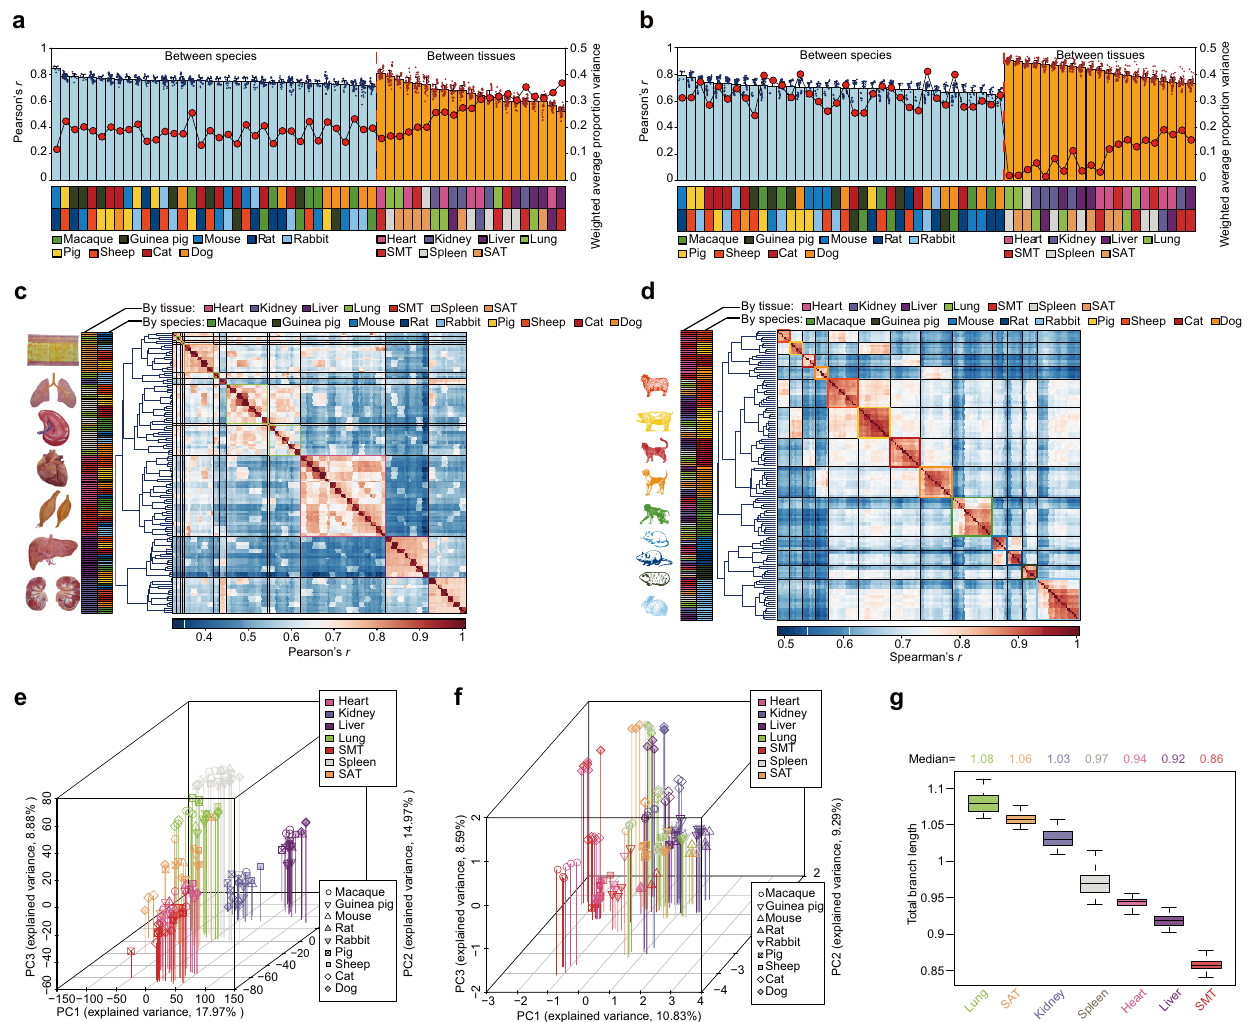
Fig. 6 Global patterns of PCG transcription and alternative splicing across mammalian models. a , b Comparison of variation between species (nine mammals) and tissues revealed by ( a ) transcription and ( b ) alternative splicing patterns. Bar plots represent pairwise Pearson ’ s correlations between species (light blue bar) and between tissues (orange bar). The correlations were calculated based on the transcription levels of 8428 1-1 orthologs and 15,172 orthologous exons across nine mammals. Data are presented as mean values ± SD. Weighted average proportion variances (WAPVs) of PCG transcription and alternative splicing (re fl ected by PSI values) were determined using principal variance component analysis (PVCA) and are depicted as red dots connected by black lines. Boxes (bottom) indicate pairwise comparisons presented in a column according to the color assigned to each species or tissue. For PCG transcription, there were more profound transcriptional differences among tissues (Pearson ’ s r = 0.66 and WAPV = 0.29) than among species (Pearson ’ s r = 0.75, WAPV = 0.18). By contrast, for alternative splicing, the differences among species (Pearson ’ s r = 0.70 and WAPV = 0.32) were greater than those among tissues (Pearson ’ s r = 0.82 and WAPV = 0.10). c , d Hierarchical clustering analysis of samples using ( c ) PCG transcription and ( d ) alternative splicing (re fl ected by PSI values). Average linkage hierarchical clustering was based on distances between transcription levels of samples measured by Pearson ’ s correlation. e , f Factorial map of the principal component analysis (PCA) of ( e ) PCG transcription levels and ( f ) alternative splicing. The proportion of variance explained by each principal component is indicated in parentheses. The vertical lines of different colors dropping from the plotted points to the x / y plane show the separation of points based on the fi rst and second principal components. g Box plot depicting the total branch lengths of neighbor-joining trees of PCG expression (see Supplementary Fig. 37) constructed based on pairwise (1 − r ) distances (here, r is Spearman ’ s correlation coef fi cient) across nine mammals for each tissue. The distribution is based on random sampling ( n = 100 replicates). In the boxplot, the internal line indicates the median, the box limits indicate the upper and lower quartiles and the whiskers extend to 1.5 IQR from the quartiles. Source data are provided as a Source Data fi guinea pig, respectively) (Supplementary Fig. 36). Relatively high We next investigated the evolutionary divergence of transcrip- similarity of transcription was also observed between the more tion between mammalian tissues by measuring the total branch closely related dog and cat [carnivores] (diverged ~55 MYA) and length of transcription-based trees for each tissue based on 8428 between pig and sheep [artiodactylids] (diverged ~64 MYA) single-copy orthologous PCGs shared by the nine mammals compared to their pairwise comparisons against other evolutio- (Fig. 6g, Supplementary Fig. 37) and found that lung tissue (total narily distant mammals (average Pearson ’ s r = 0.77 between cat branch length = 1.08) and SAT (1.06) had longer total branch and dog vs. 0.74; Pearson ’ s r = 0.79 between pig and sheep vs. lengths than other tissues (kidney [1.03], spleen [0.97], heart 0.76) (Supplementary Fig. 36). [0.94], liver [0.92], and SMT [0.86]), implying a potentially higher